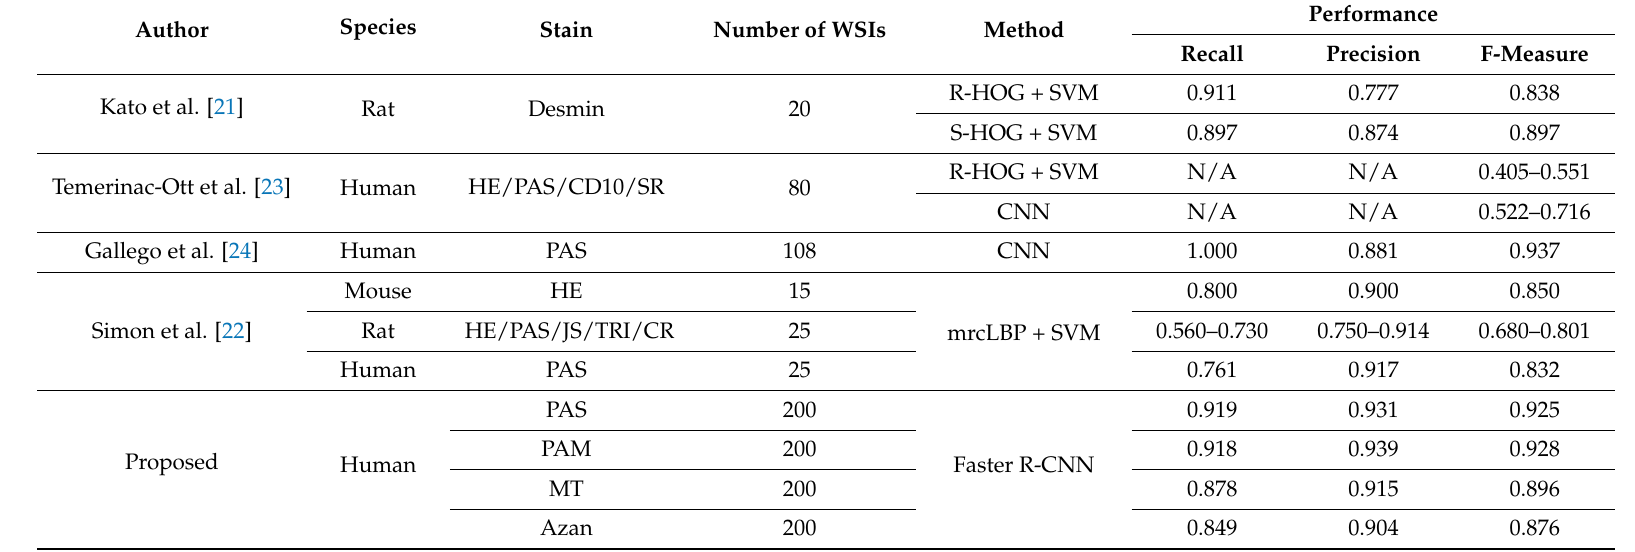
Table 3. The performance of glomerular detection in previous studies and proposed